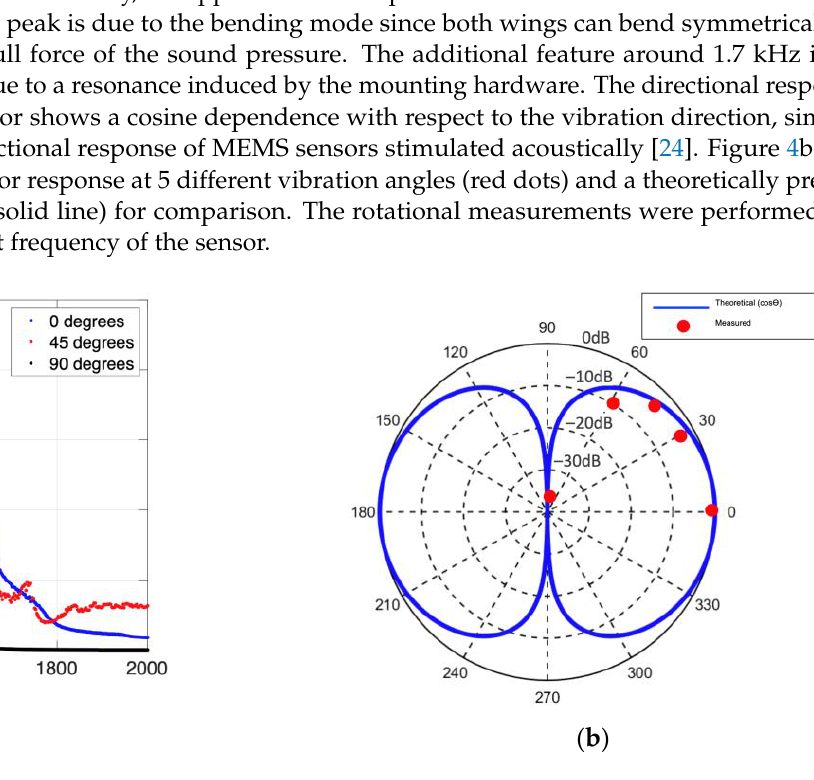
Figure 4. ( a ) Frequency-dependent sensitivity (V/g) of the MEMS sensor mounted on a shaker at 3 different angles. The insets are FE simulations of the bending and rocking vibrational modes at 1600 and 1440 kHz, respectively. ( b ) Directional response at resonance at 5 different vibration angles (circular markers) along with the cosine of the vibration angle (solid line). The magnitude scale in the polar plot represents the measured voltage normalized by the maximum value obtained at zero degrees.